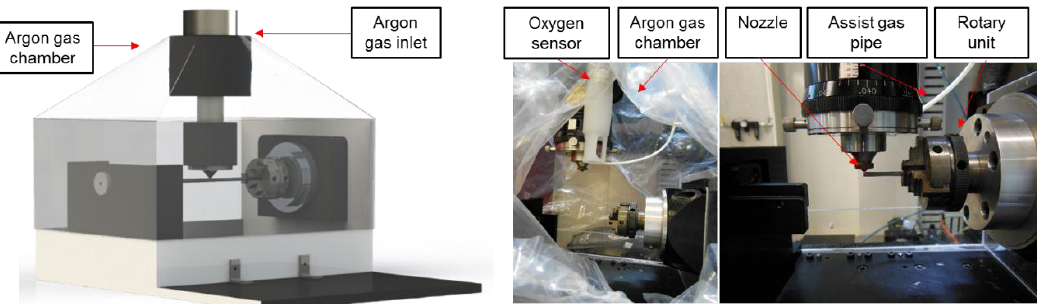
Figure 1. Experimental setup.